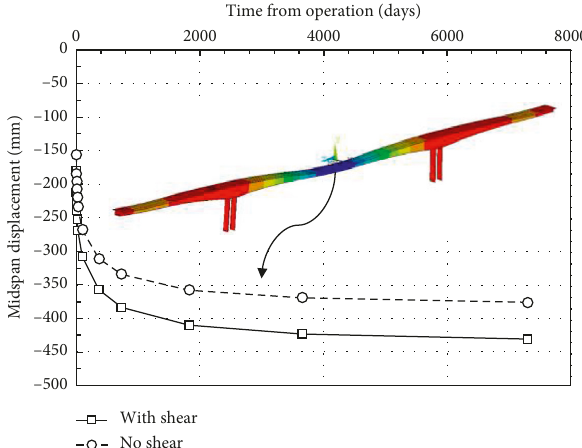
Figure 7: Long-term midspan deflection of a continuous rigid bridge with a main span of